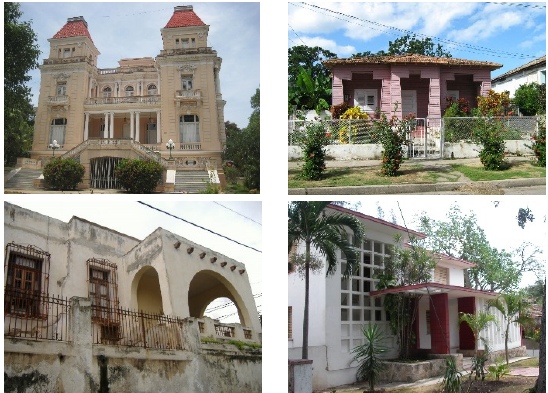
Figure 2. Examples of Vista Alegre’s architectural collection. Note the integration of green areas. Source: authors’